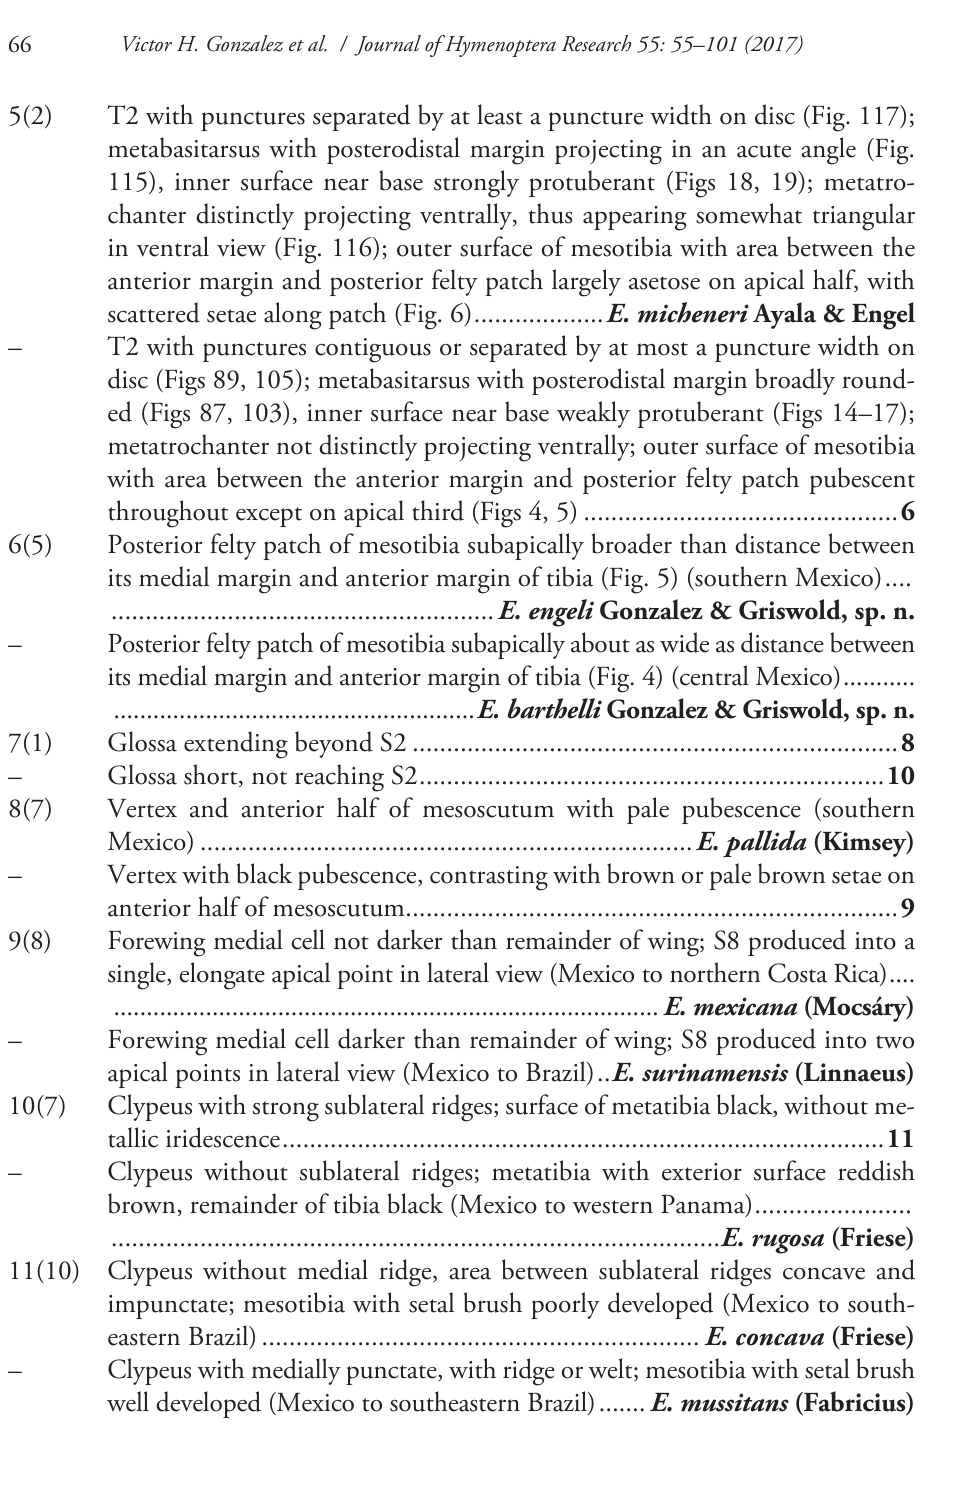
Clypeus with strong sublateral ridges; surface of metatibia black, without me- – Clypeus without sublateral ridges; metatibia with exterior surface reddish